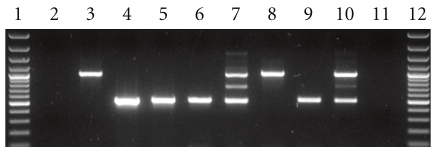
Figure 3: Agarose gel showing the results of a mycoplasma detec- tion PCR. Two PCR reactions were performed per sample: one with the sample only and one with the sample and an internal control DNA added at a limiting dilution. The wild-type PCR product is represented by the lower band with a size of approximately 520 bp. The upper band is the amplification product of the internal control DNA (986bp). (1) 100 bp ladder, (2) mycoplasma-negative cell line, (3) mycoplasma-negative cell line with internal control, (4) A. laidlawii -contaminated cell line, (5) A. laidlawii -contaminated cell line with internal control, (6) M. hyorhinis -contaminated cell line, (7) M. hyorhinis -contaminated cell line with internal control (the intermediate band at approximately 750 bp is a hybrid of a 520bp and a 986 bp product), (8) internal control only, (9) positive control only, (10) positive control with internal control, (11) water control, and (12) 100 bp